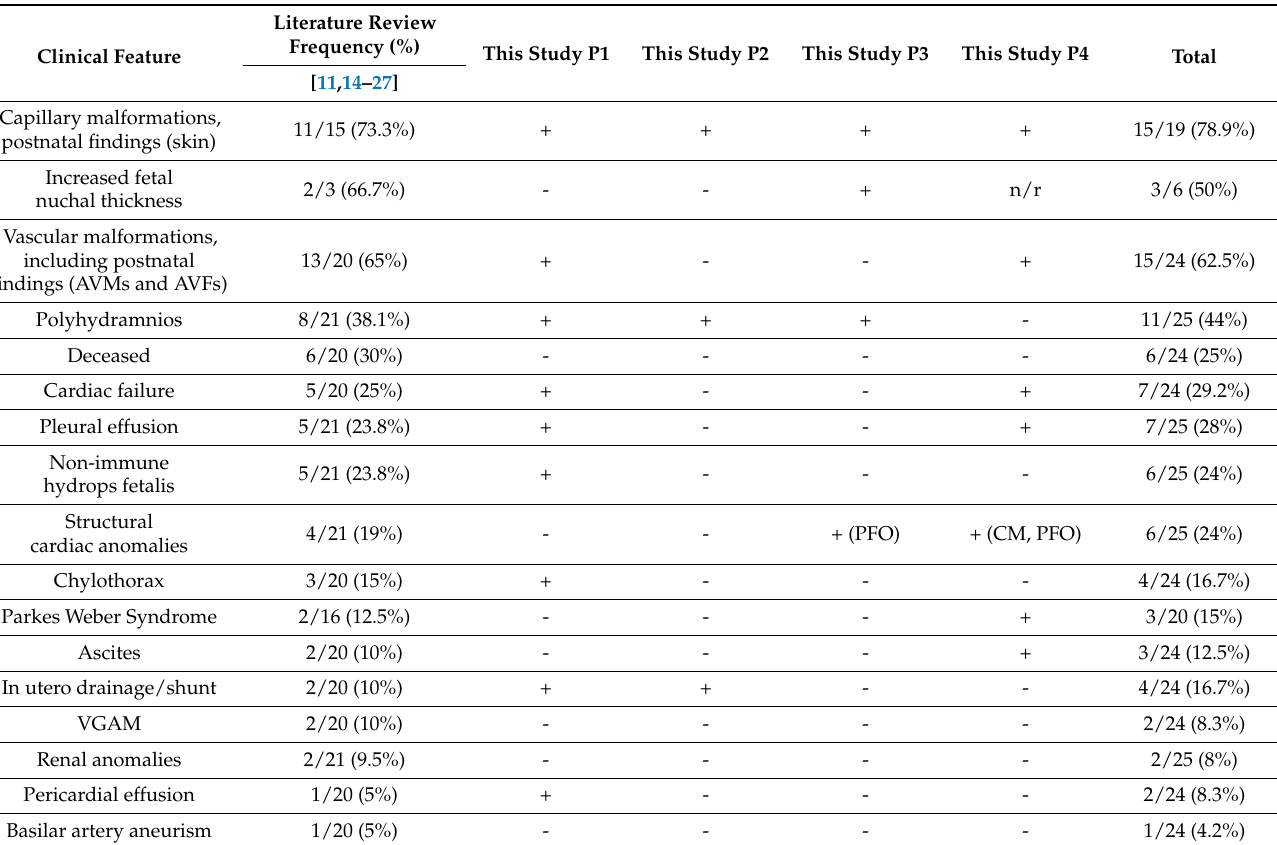
Table 1. CM-AVM syndrome clinical features in previously reported cases [11,14–27], characterized by a prenatal onset of symptoms, in order of frequency and compared with our patients’ characteristics. Abbreviations: AVMs, arteriovenous malformations; AVF, arteriovenous fistulas; VGAM, vein of Galen aneurysmal malformations; PFO, patent foramen ovale; CM, cardiomegaly; n/r, not